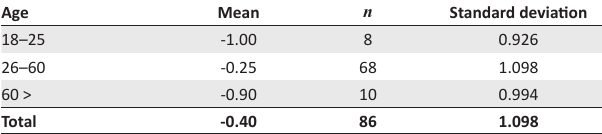
TABLE 10: Changes in disaster loss (mean score of age).